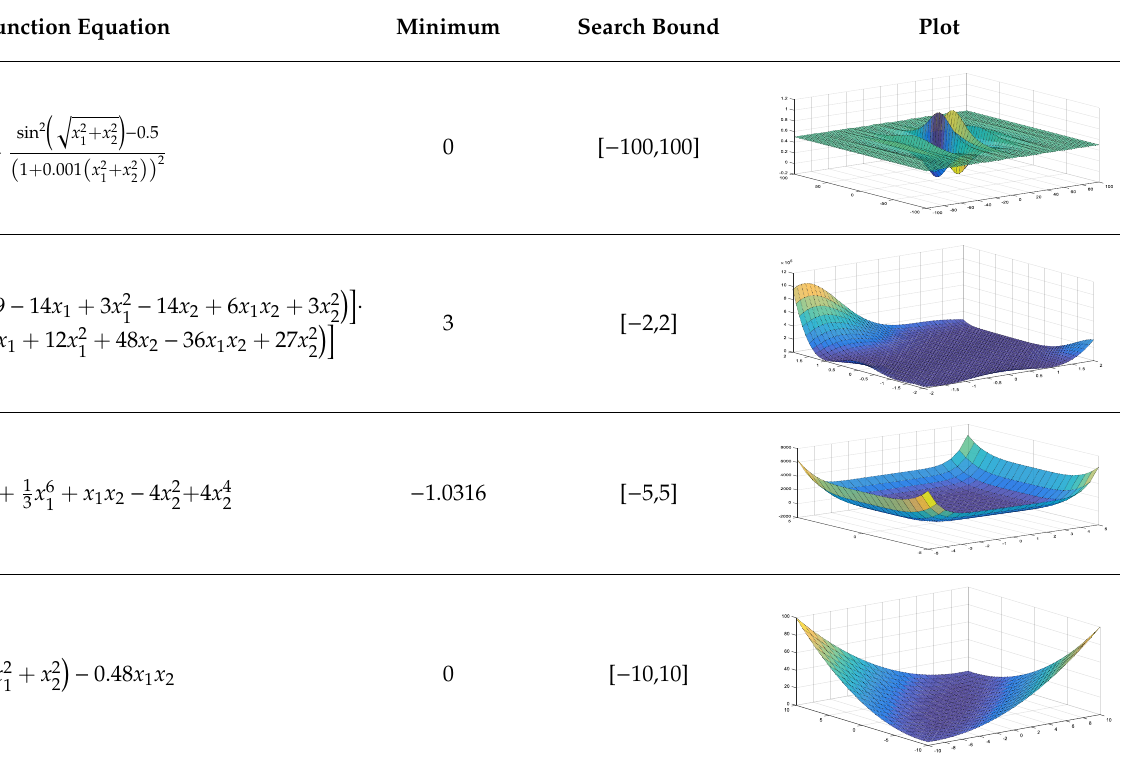
Table 1. Benchmark functions optimized using the VS algorithm.